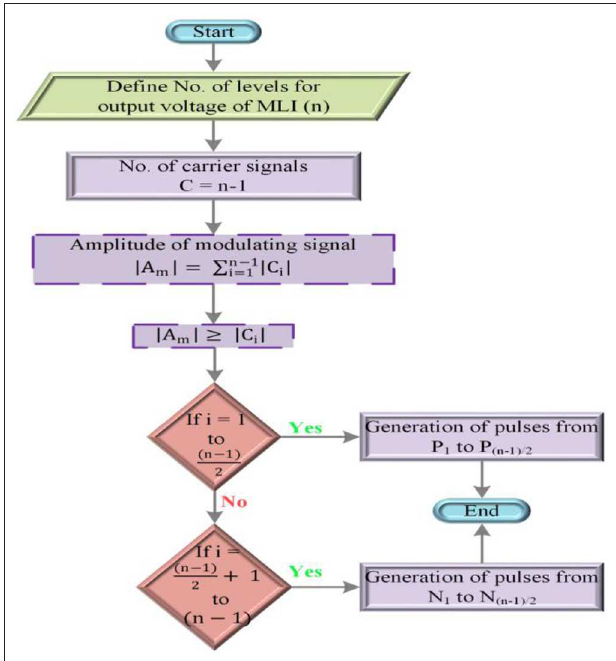
FIGURE 2 | Flowchart for calculation of number of carrier waves and generation of pulses.